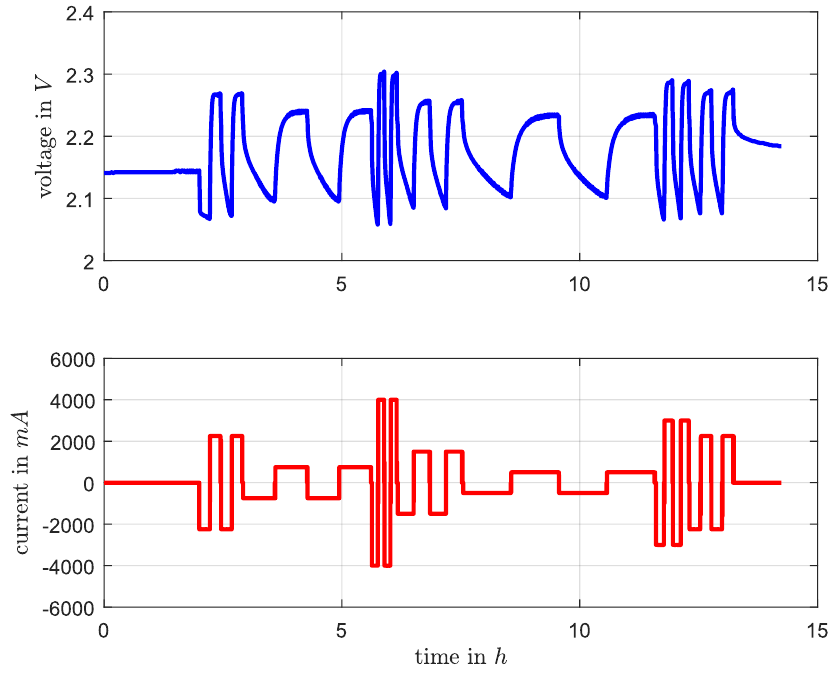
Figure 1. The voltage and current profiles of the EIS set containing different superimposed DC-currents in charging and discharging direction.